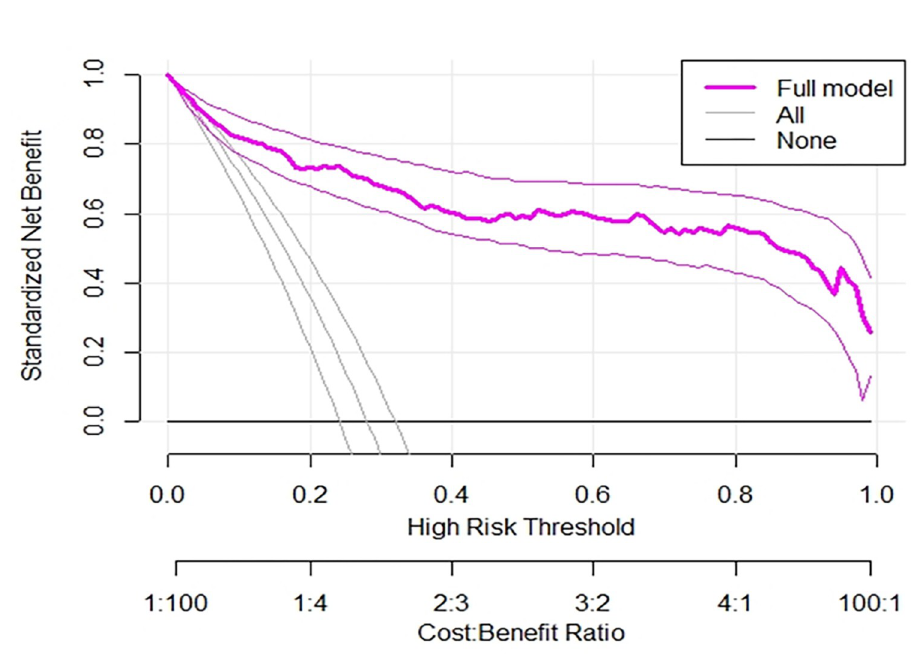
Fig 3. A plot of decision curve illustrating the net benefit of the model against threshold probability and corresponding cost-benefit ratio of poor outcomes of SCAP in under-five children.